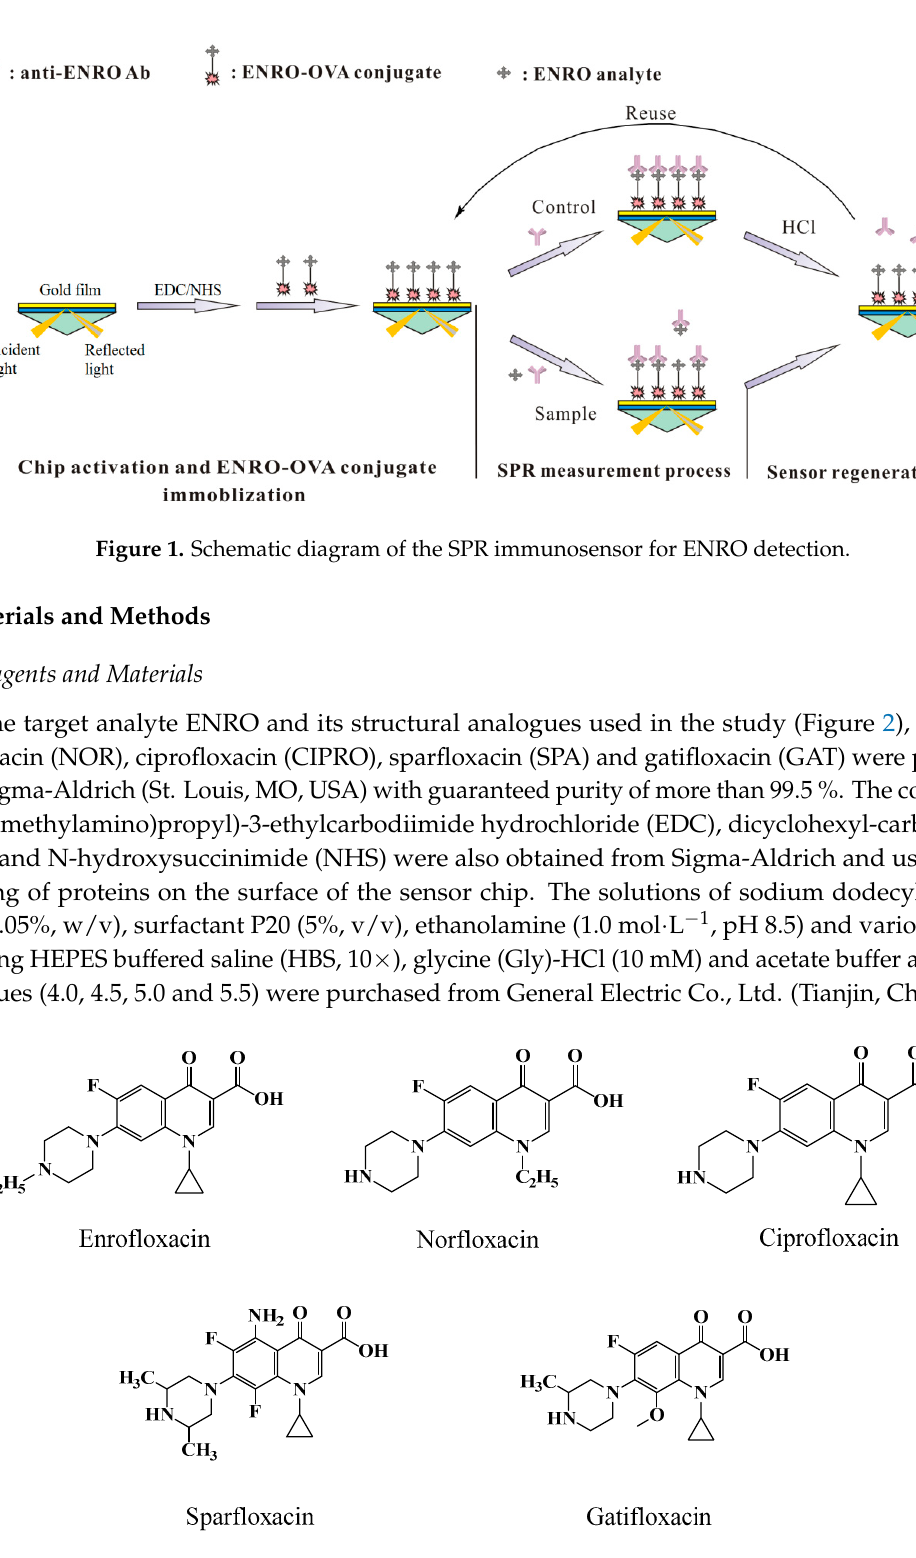
Figure 2. The chemical structure of target analyte ENRO and its analogues NOR, CIPRO, SPA and GAT.